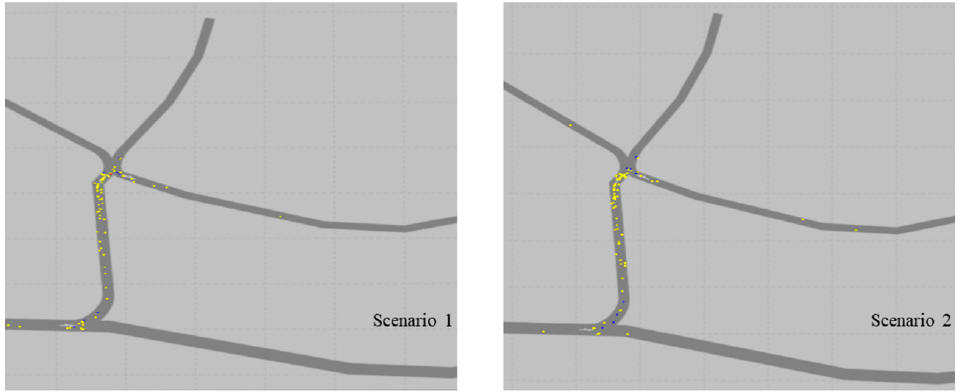
Figure 14. Number of conflicts by severity in intersections.